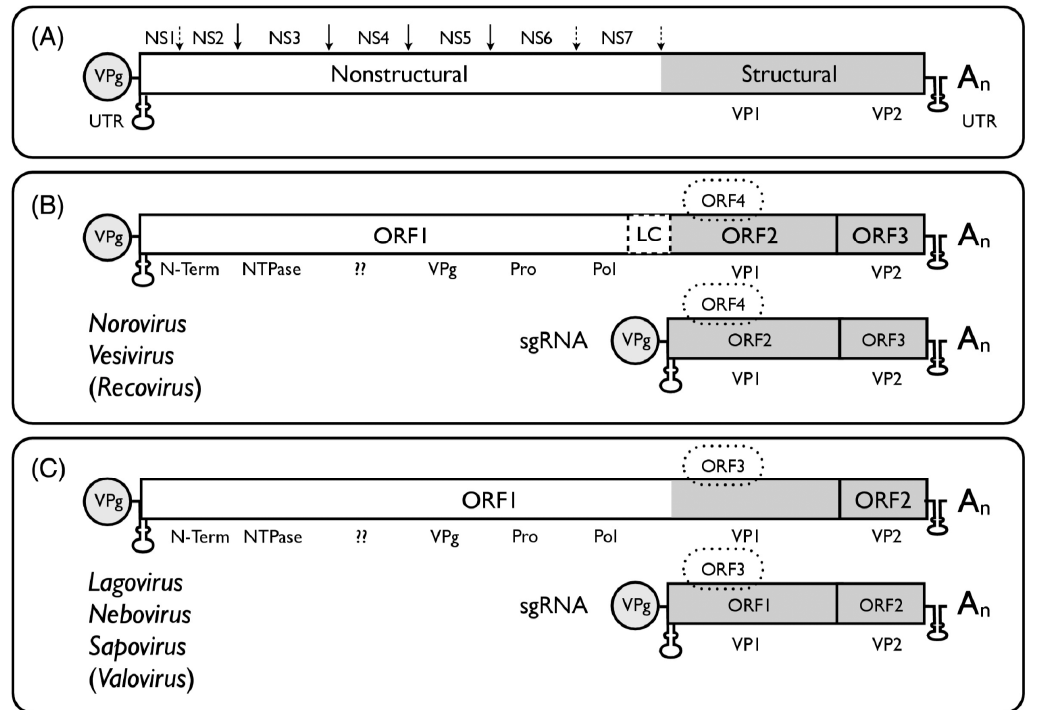
Figure 1. Schematic genome organization of viruses in different genera of the Caliciviridae . ( A ) The long ORF encodes a polyprotein consisting of seven mostly non-structural proteins (ORF1) and 2–3 structural proteins (ORF2–ORF4). ( B ) NS3 encodes an NTPase, NS5 the VPg (a structural protein), NS6 a protease, NS7 the RNA-dependent RNA polymerase (RdRp). NS1, NS2 (NS1 + NS2 are also called N-Term), and